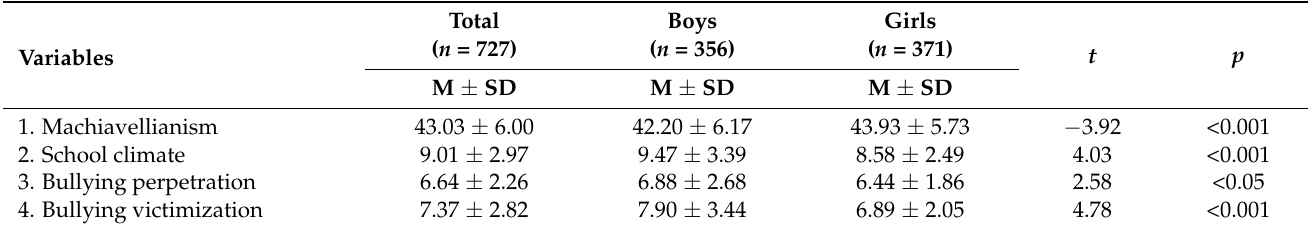
Table 1. Means, standard deviations, and sex differences among the primary